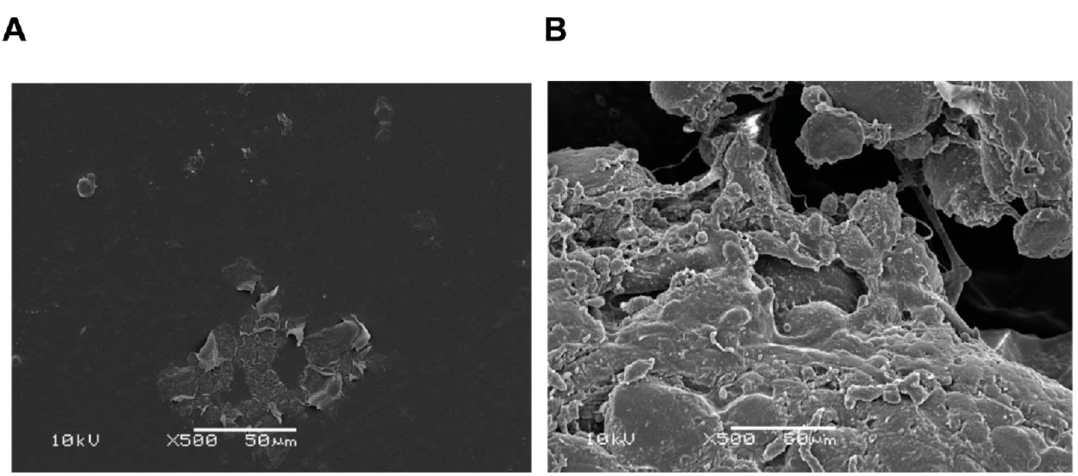
Figure 2. Scanning electron micrographs of biofilm on ( A ) smooth and ( B ) textured implants in female pigs and inoculated with a human strain of Staphylococcus epidermidis . Results were confirmed by quantitative polymerase chain reaction [83] .